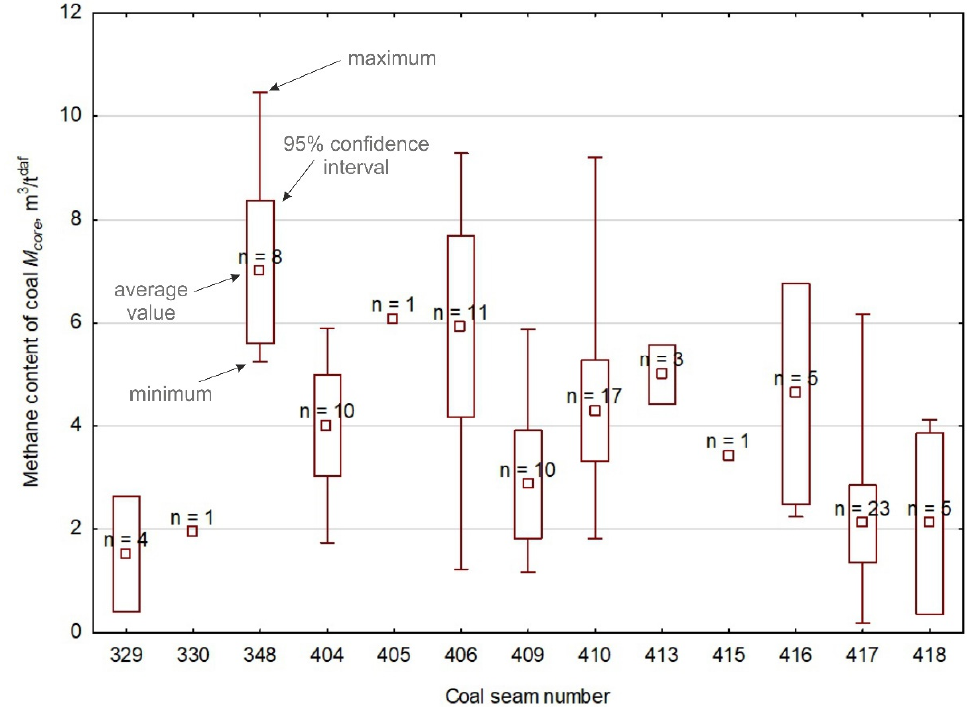
Figure 5. Variation of methane content of coal in particular seams (n is the number of coal samples pairs in a coal